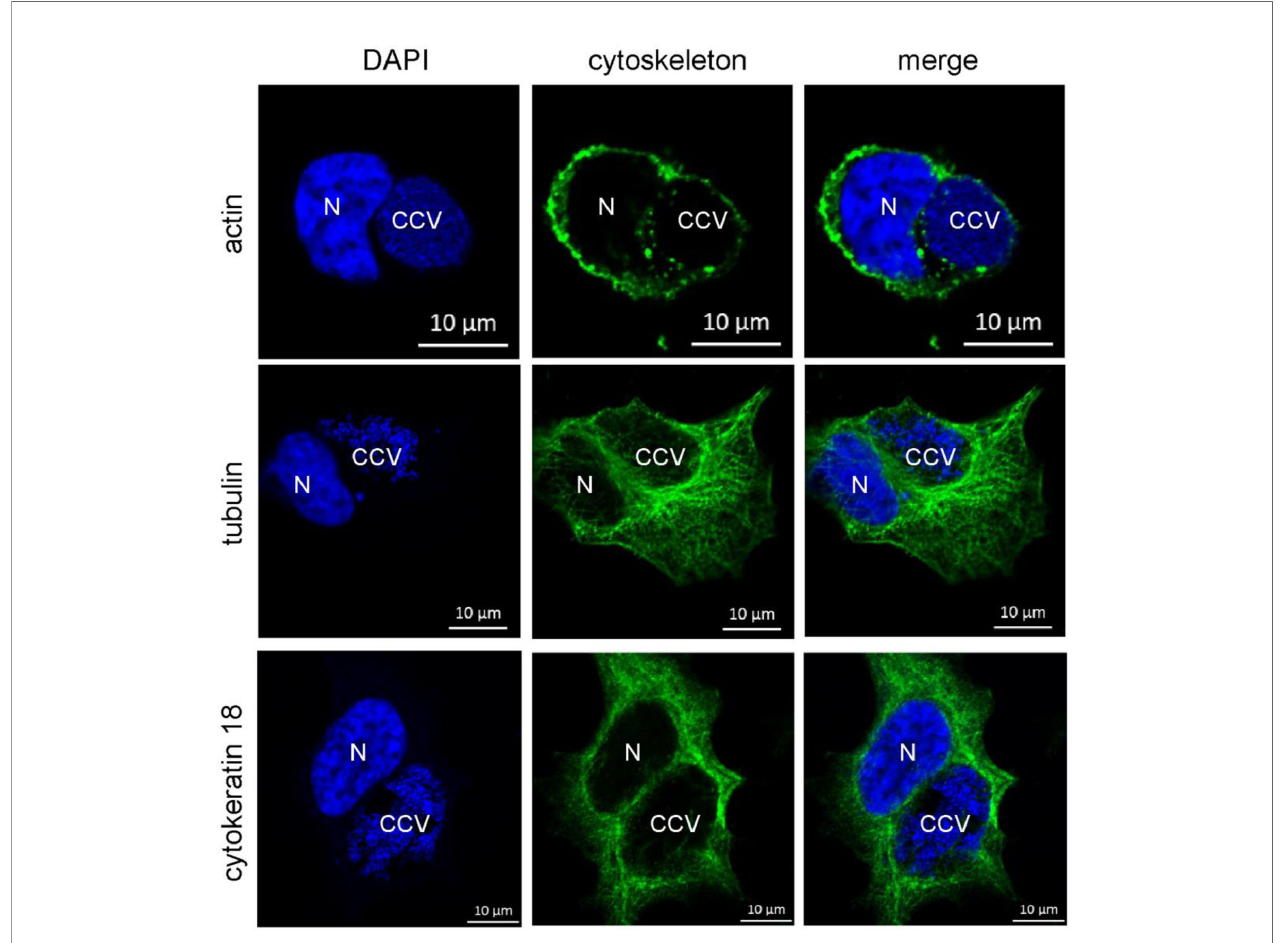
FIGURE 10 | Cytoskeletal fi laments decorate the CCV. HeLa cells were infected with C. burnetii at an MOI of 50. At 72 h post-infection, cells were fi xed and stained with Phallotoxin-647 for actin, or with tubulin- and cytokeratin 18-speci fi c antibodies by indirect immuno fl uorescence (green). Nuclei and bacterial DNA were stained with DAPI (blue). Cells were visualized using LSM. N: Nucleus. CCV: C. burnetii -containing